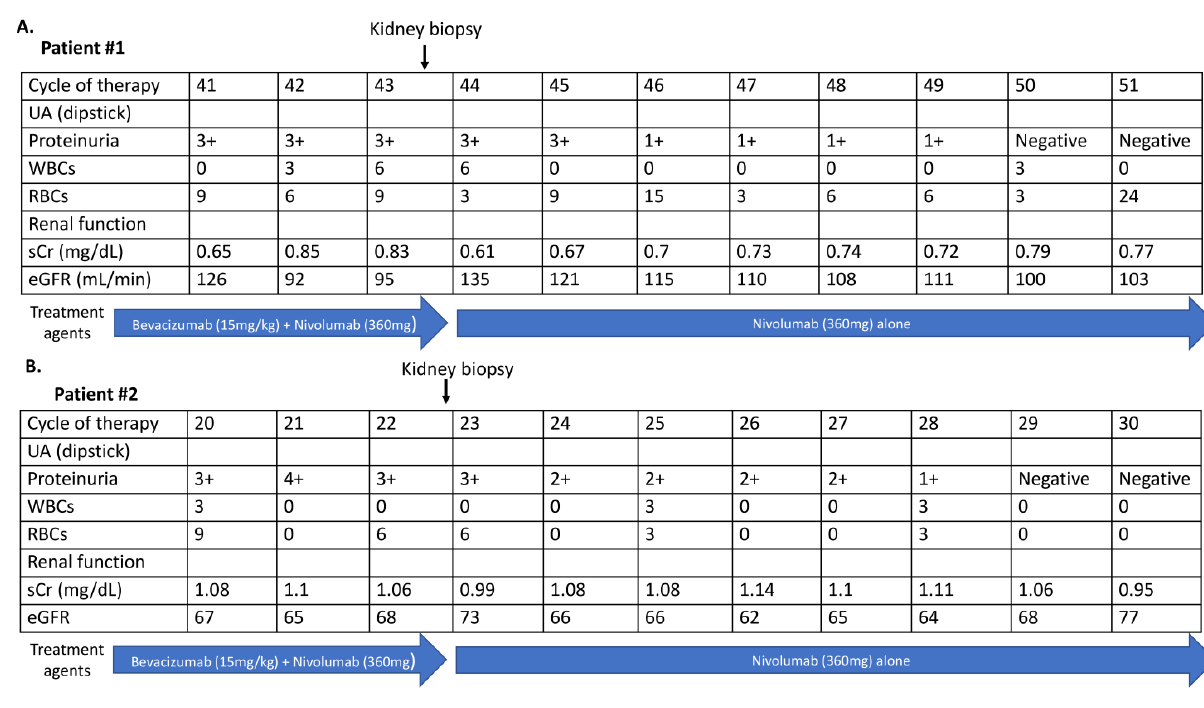
Figure 3. The changes in proteinuria detected by dipstick UA, renal function, and treatment agents in the 2 patients. ( A ) Patient #1, ( B ) Patient #2. Abbreviations: UA, urine analysis; WBCs, white blood cells; RBCs, red blood cells; sCr, serum creatinine; eGFR, estimated glomerular filtration